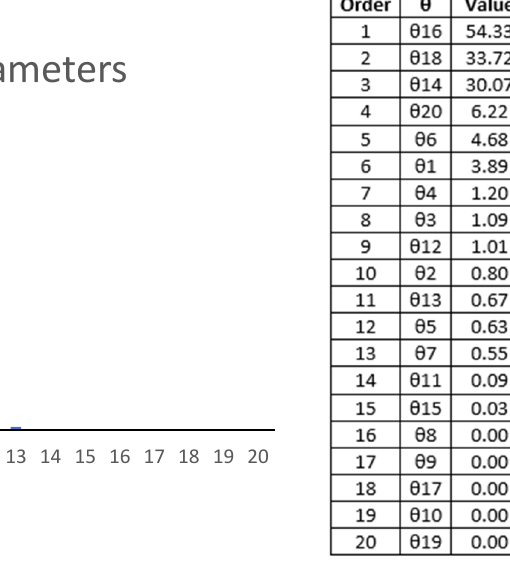
Figure 8. PIP values for the chosen model. Values lower than 0.03 are excluded from the model, so the parameters θ 8 , θ 9 , θ 17 , θ 10 and θ 19 are excluded from the model.